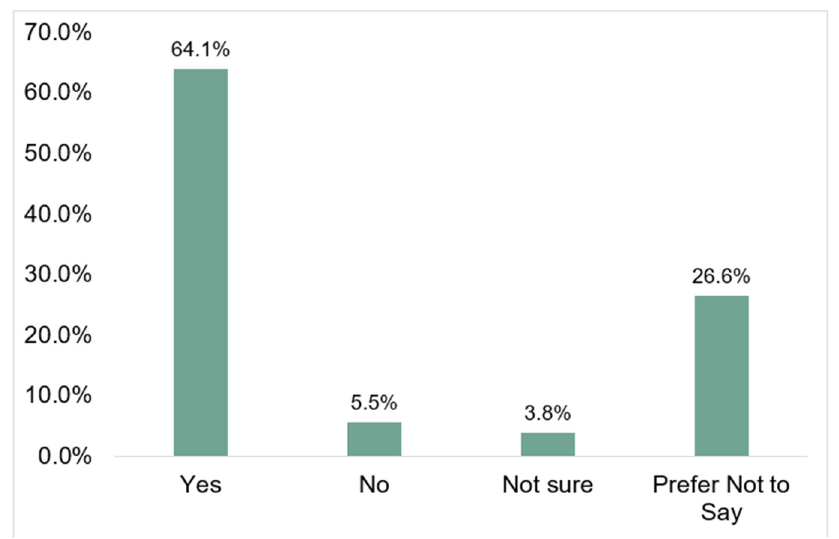
Figure 1. Percent of respondents who plan to obtain the COVID-19 vaccine by response category ( N = 1648) .